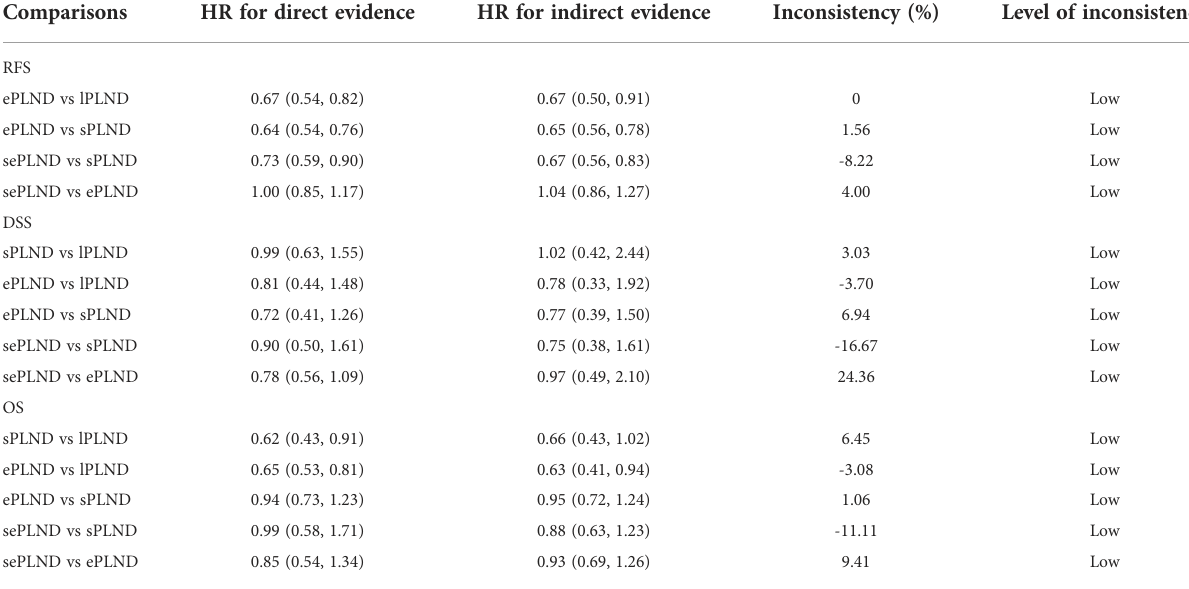
TABLE 2 Inconsistency between direct evidence and indirect evidence.